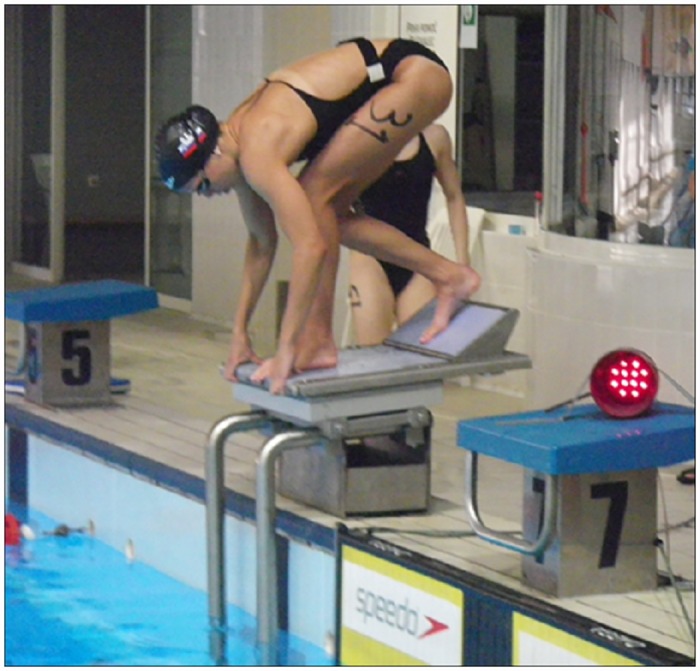
Swimmer ready to perform the freestyle track start.Note: The individual in this picture has given written informed consent (as outlined in PLOS consent form) to publish this photograph.